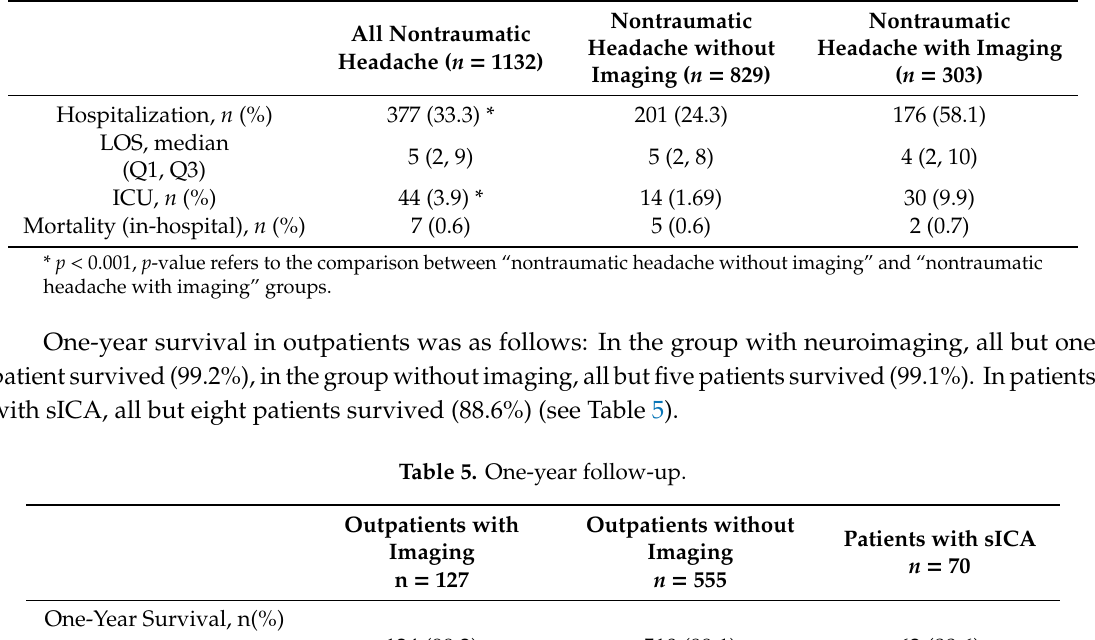
Table 4. Outcomes.